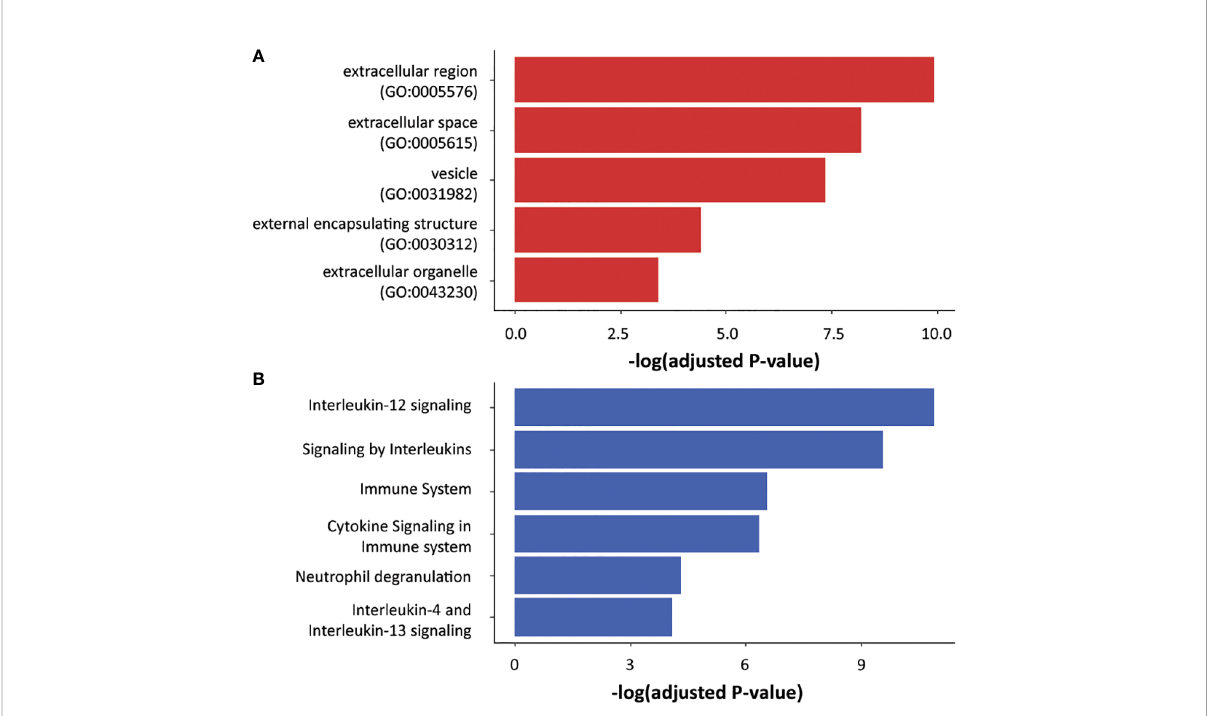
FIGURE 2 Ontology terms enrichment for the identi fi ed proteins. The 79 proteins identi fi ed by mass-spectrometry were analyzed for overrepresented GOCC (A) and Reactome (B) terms. The signi fi cant terms that are associated with secretion and immune system are